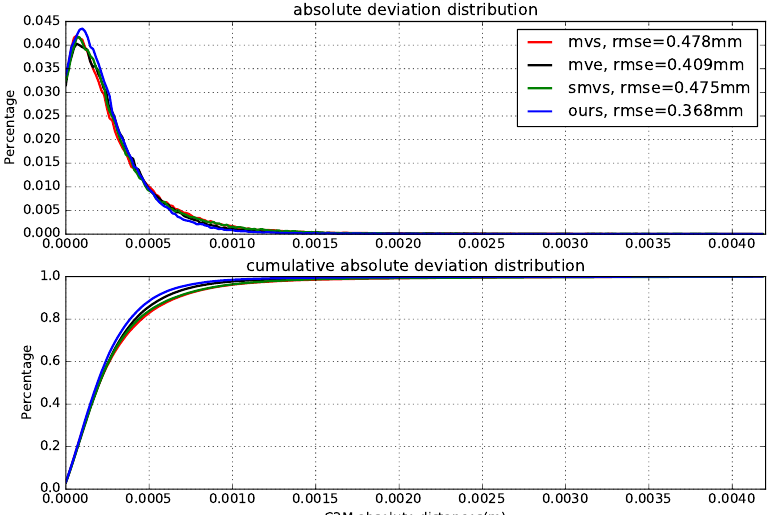
Figure 16. Normalized model deviation histograms and the cumulative distributions. The C2M (cloud to mesh) deviation histograms are output from CloudCompare software [42], and the respective root-mean-square error (rmse) is given in the legend. Table 3. Ratio of pixels with absolute errors less than 1 mm and 5 mm on synthetic Caesar .